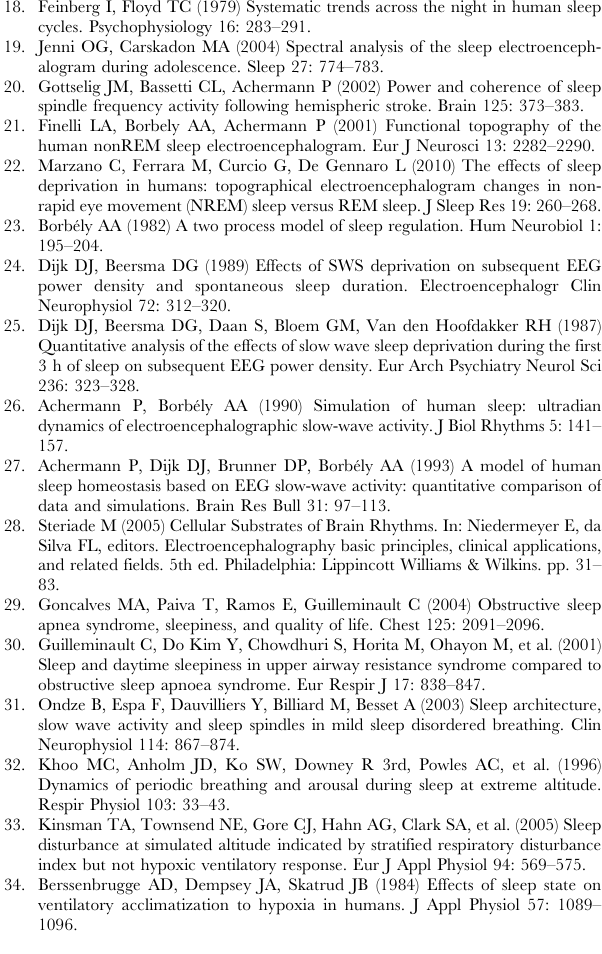
altitude, n= 23) and HL (descending from higher to lower altitude, n =21). The difference between the two groups in the central apnea/hypopnea index (AHI) and oxygen desaturation index (ODI) was evaluated by comparing the differences between altitude and baseline values of the two groups. For oxygen saturation (SpO2) the absolute values were compared. *p , 0.05, + p , 0.1 (Wilcoxon signed rank test) altitude compared to baseline. { p , 0.05 (Mann-Whitney U test) Comparison of the difference baseline-altitude between the groups HL and LH. Oxygen saturation, central apnea/hypopnea index and oxygen desatura- tion index were averaged over total non-REM